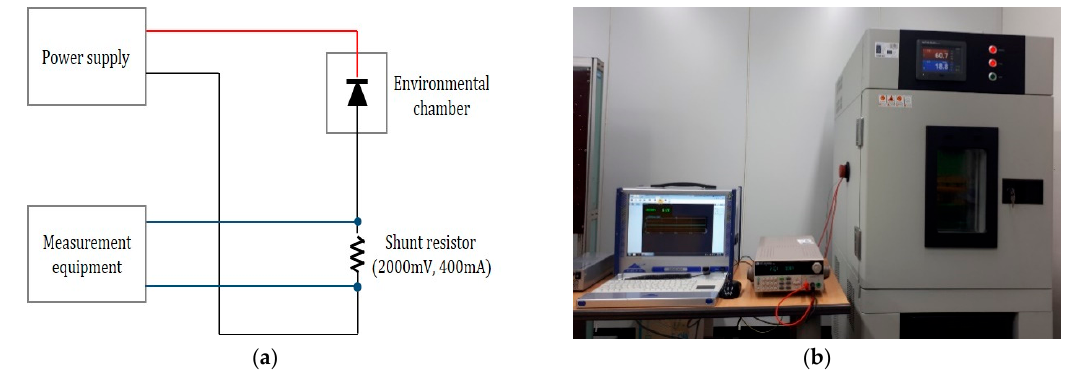
Figure 3. ( a ) Schematic diagram and ( b ) experimental equipment for measuring the current of a bypass diode at various temperatures.